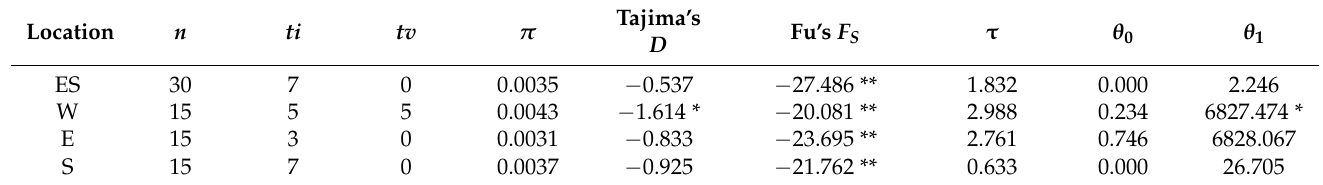
Table 4. Summary of the mtDNA sequence variability for populations of N. phocaenoides .